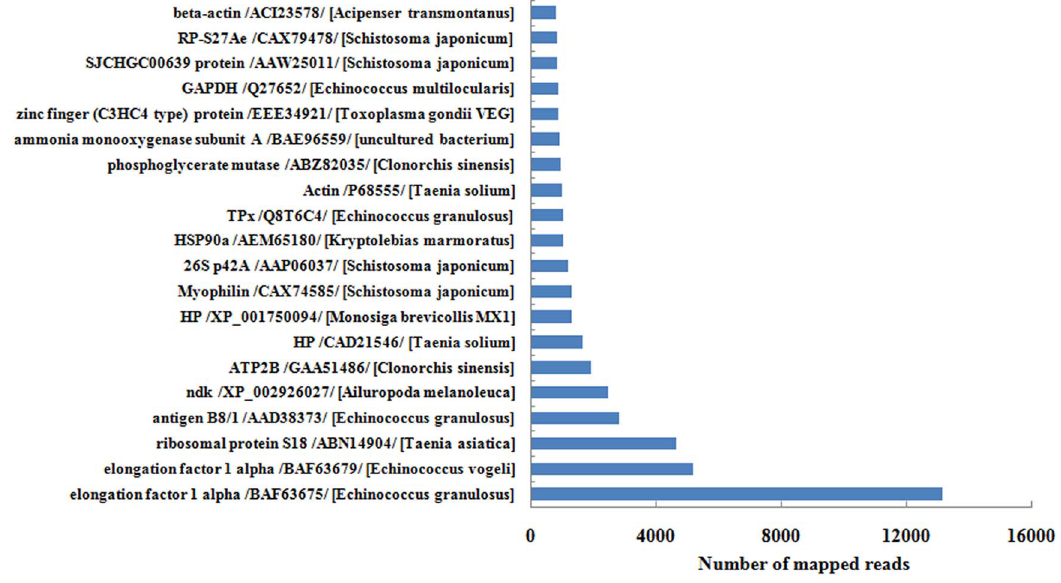
Fig. 2. The transcription profiling of putative ESPs in Eg PSCs transcriptome. The 20 most abundant ESPs encoded in the transcriptome are shown. Abbreviations: RP-S27Ae, putative small subunit ribosomal protein S27Ae; GAPDH, glyceraldehydes-3-phosphate dehydrogenase; ndk, nucleoside diphosphate kinase B-like; ATP2B, Ca 2 + transporting ATPase plasma membrane; HSP90 a , heat shock protein alpha; 26S p42A, 26S proteasome regulatory complex subunit p42A.